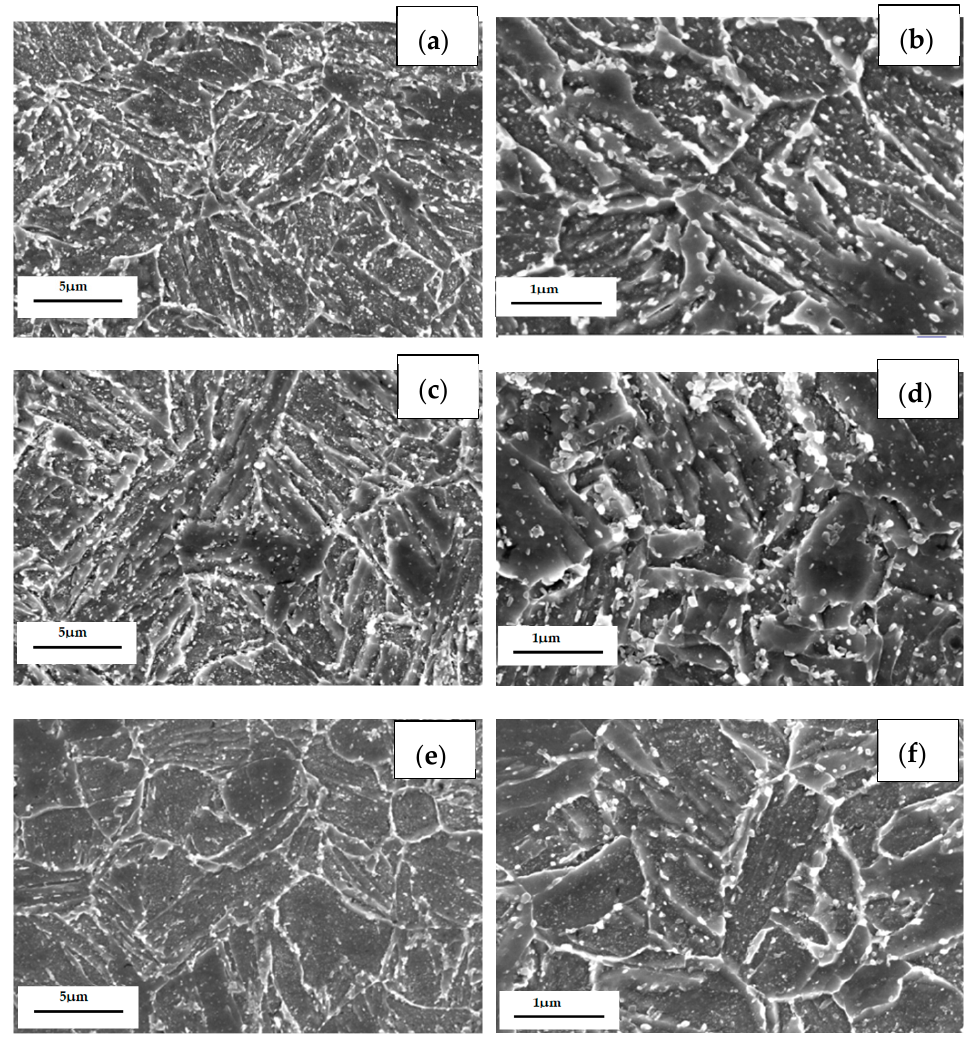
Figure 10. SEM micrographs of ( a ) steel A, ( c ) steel B and ( e ) steel C specimens; ( b , d , f ) are higher magnification images of ( a , c , e ).